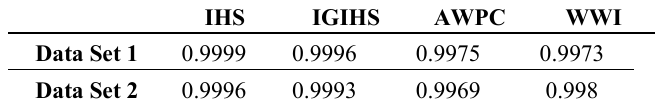
Table 3. Closeness of high resolutions fused and initial pan-image MTF